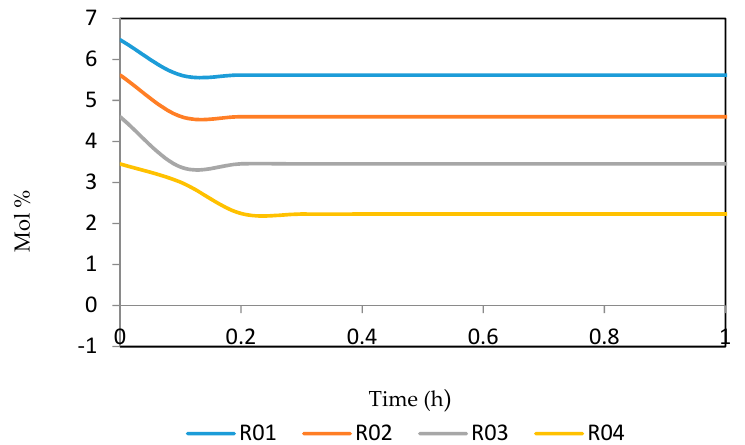
Figure 21. Dynamic behaviour of N 6 in the four reactors.